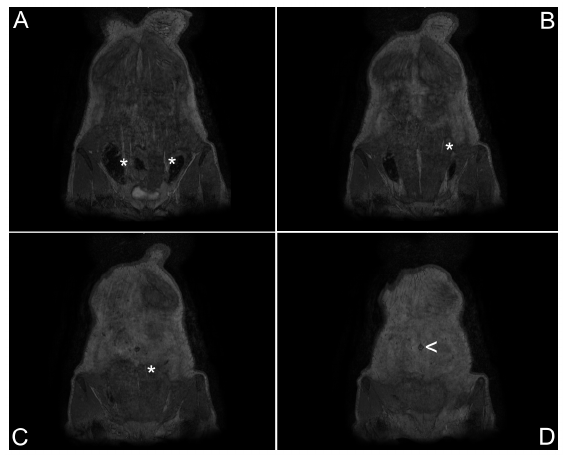
Figure 4. Coronal slices demonstrate the course of perforator branches traversing the rectus muscles. Coronal reformations of equilibrium-phase source images from dorsal (panel A) to ventral (panel D) clearly demonstrate the course of the small perforator branches (asterisks) traversing the rectus muscles. The umbilicus (arrowhead, panel D) is clearly visualized and serves as the reference location for determining the exact point where the perforator branches arise from the muscle. The left side is dominant.